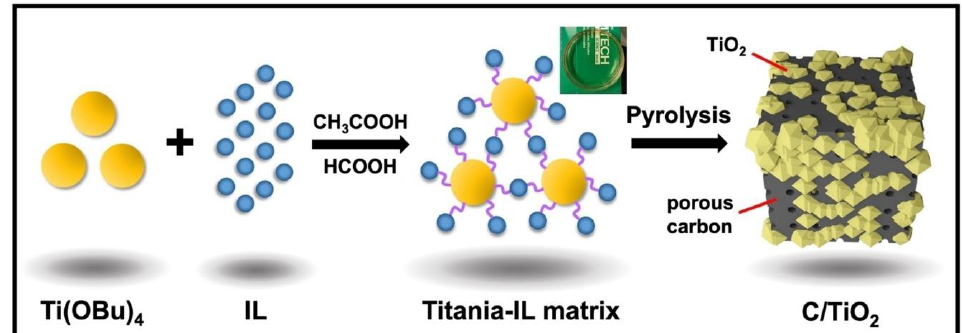
Figure 5. An illustration of C/TiO 2 composite synthesis via ionothermal synthesis, the purple curved line represents hydrogen bonding between Titania and ILs through non-hydrolytic sol-gel process Reprinted with permission from Ref. [68]. 2022, John Wiley and Sons.